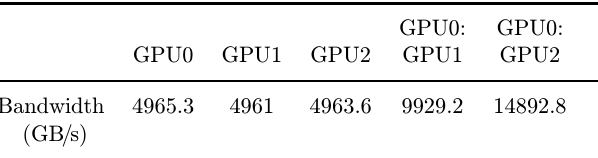
Table 1. Host to device bandwidth.